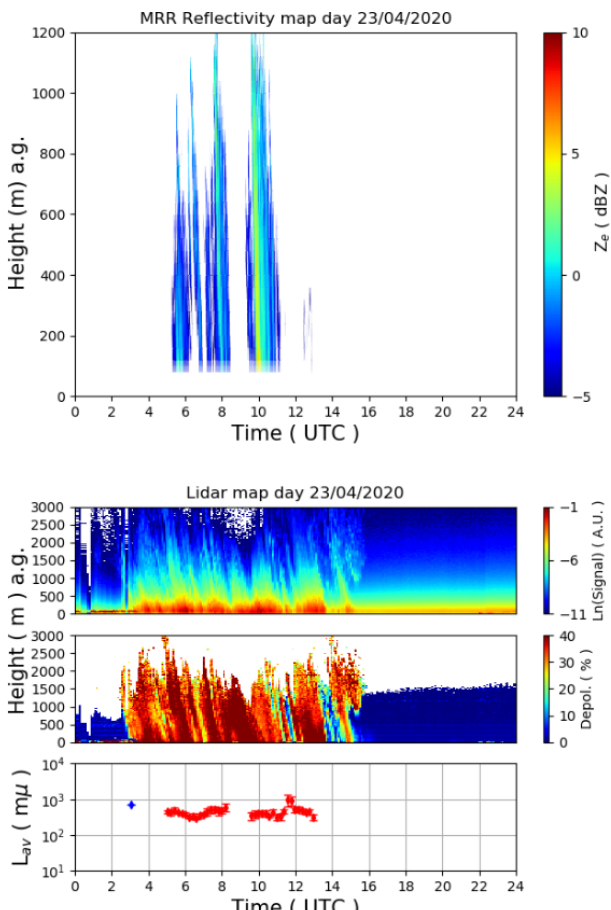
Figure 24. As for Fig. 17 but for the day of 23 April